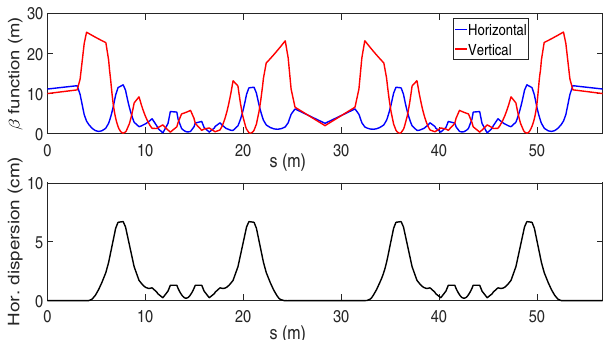
FIG. 1. Lattice function in the standard achromat section of the HEPS 6 GeV storage ring, which is composed of 24 such similar